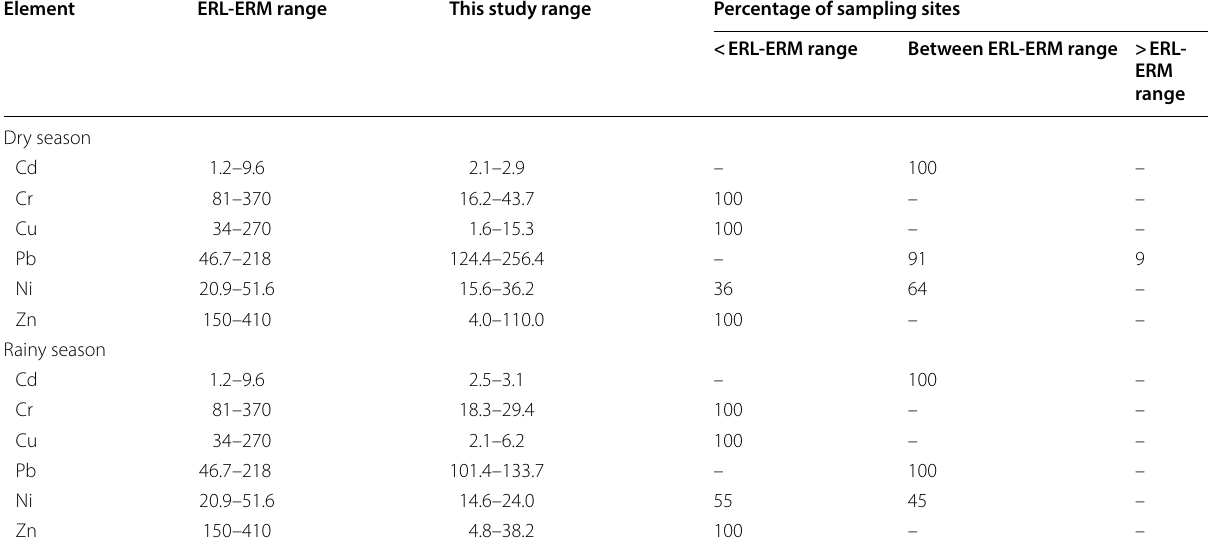
Table 6 Concentrations of trace metals in River and reservoir sediment and its comparison with ERL-ERM ranges of SQGs (mg/kg, dry wt) Element